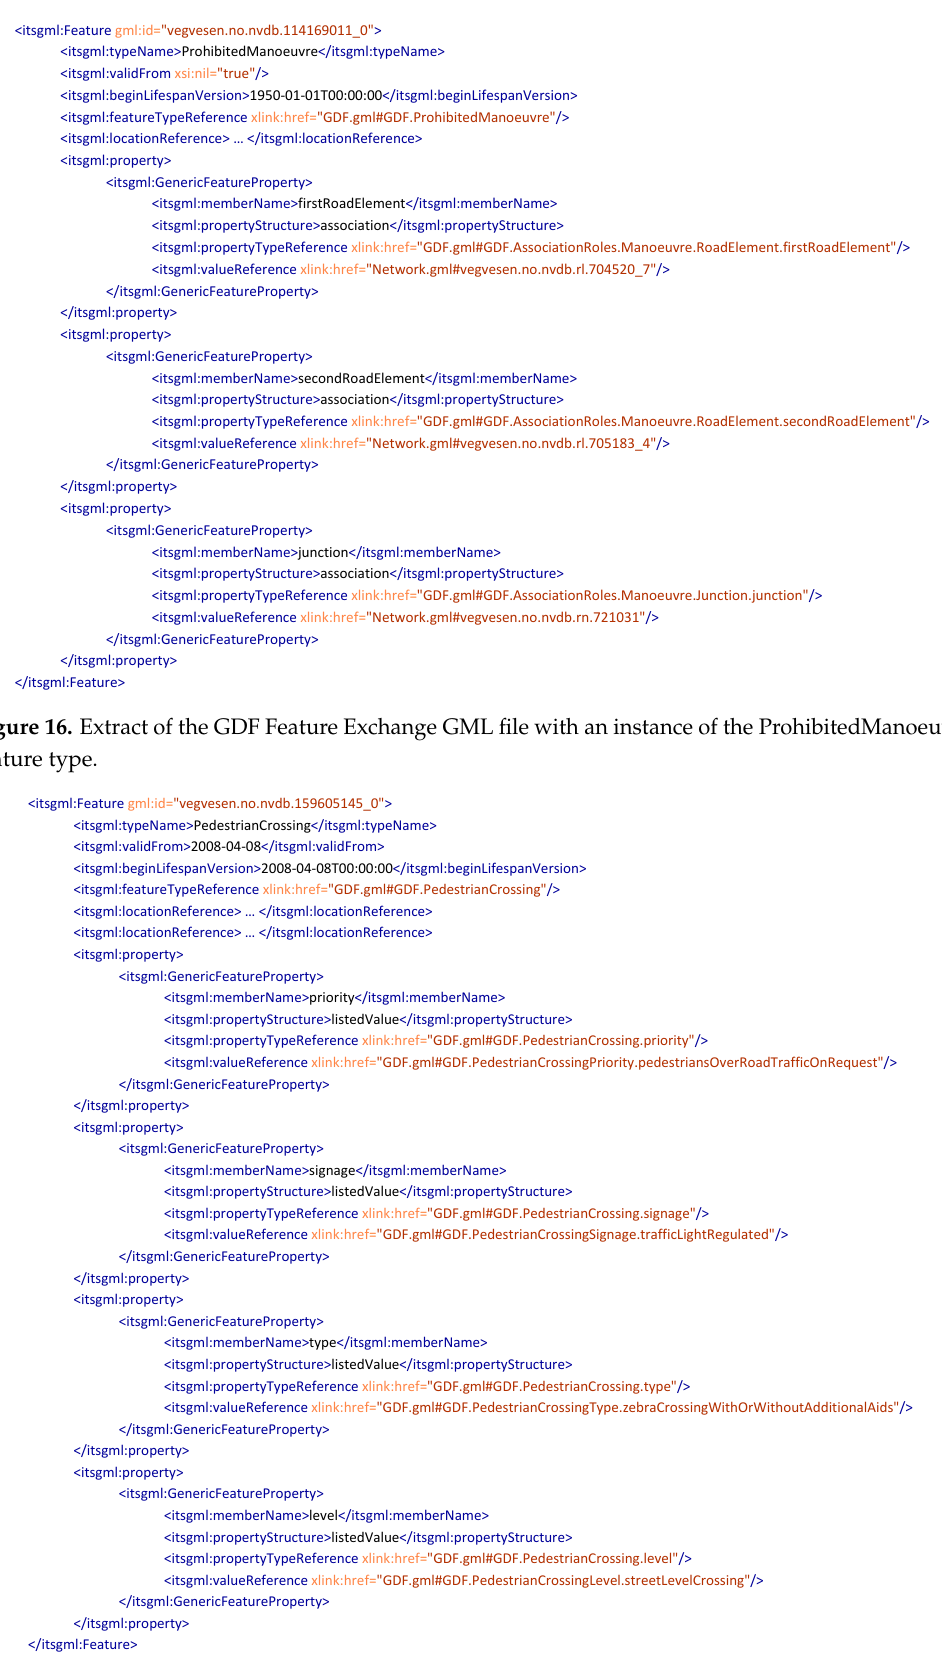
Figure 17. Extract of the GDF Feature Exchange GML file with an instance of the PedestrianCrossing feature type.